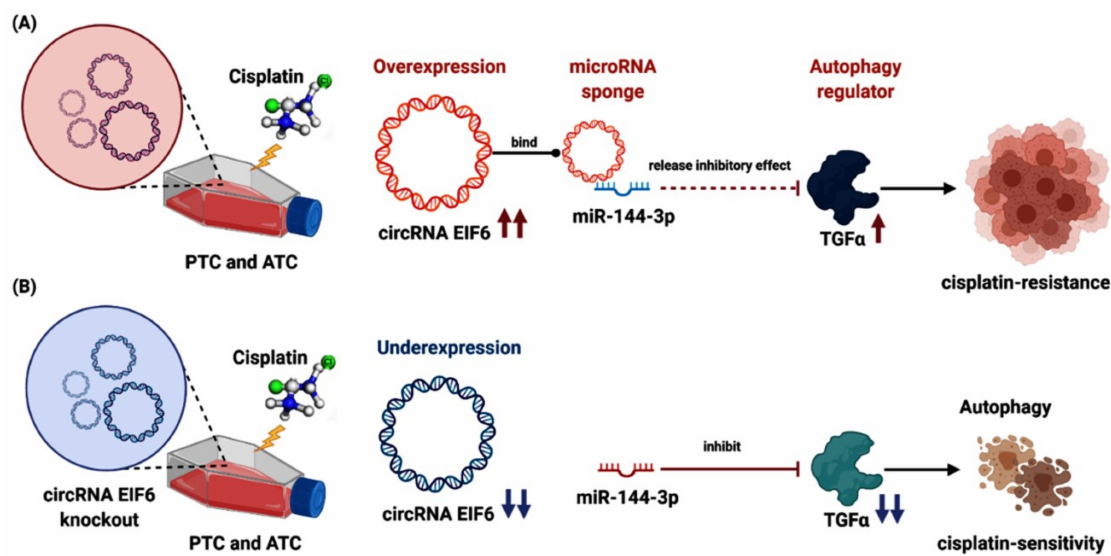
Figure 5. CircRNAs and chemotherapy drugs in thyroid cancer. ( A ) The role of overexpressed “circEIF6”, its target miR-144-3p, and downstream “transforming growth factor- α (TGF- α )” in cis- platin resistance in papillary and anaplastic thyroid cancer cell lines. CircEIF6 sponges miR-144-3p to promote the cisplatin resistance of human TC cells by autophagy regulation. TGF- α activation accelerates the carcinogenesis process and cisplatin resistance. ( B ) Knockout of “circEIF6” reverses the processes mentioned above, sensitizing the papillary and anaplastic thyroid cancer cell lines to cisplatin (Created by